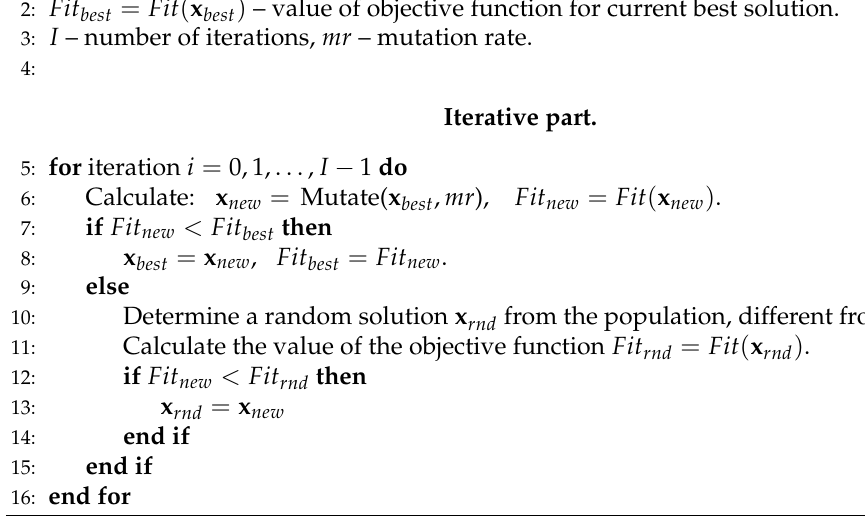
Algorithm 6 Dynamic butterfly optimization algorithm (DBOA)